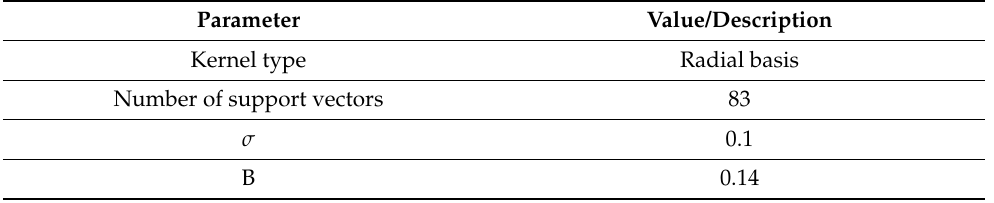
Table 2. SVM Model.